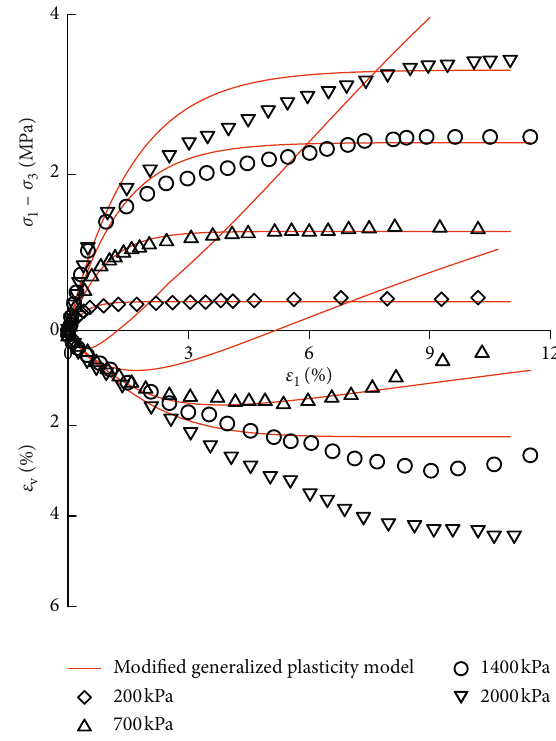
Figure 10: Predictions of modified generalized plasticity model for CP